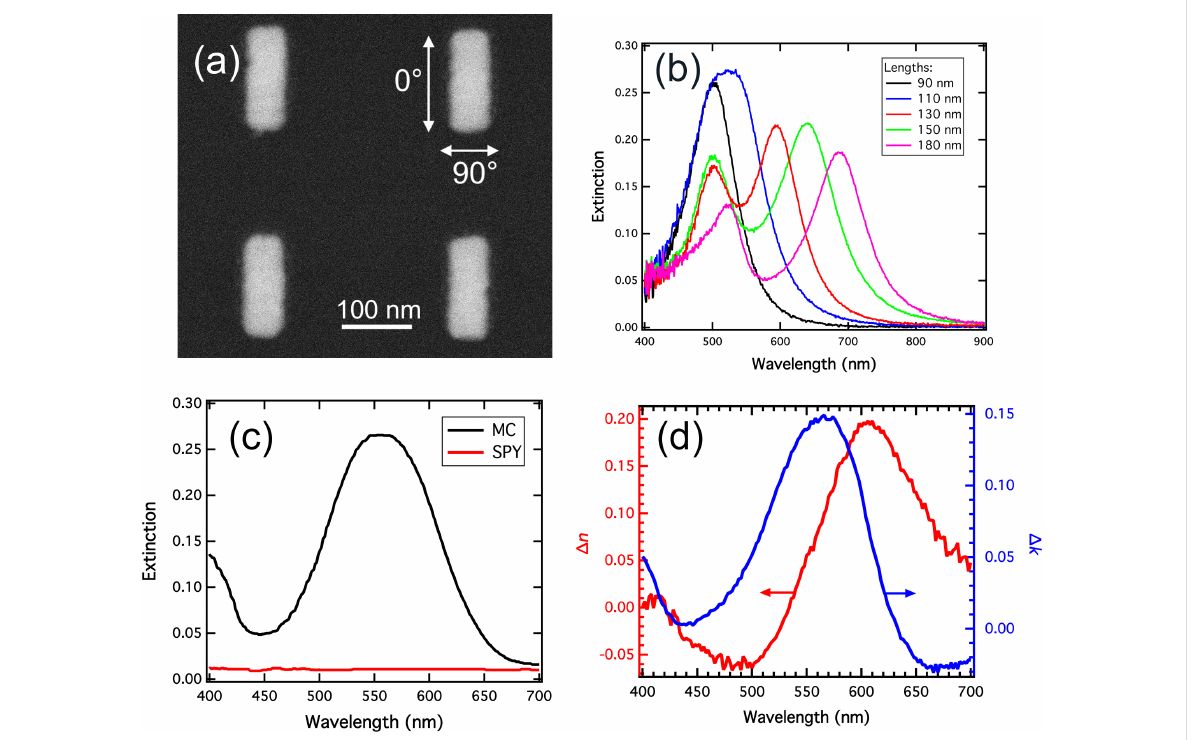
Figure 1: (a) SEM image of silver nanorods. The 0° and 90° polarization orientations correspond to the nanorod long and short axes, respectively. (b) Extinction spectra of silver nanorods in air. The width is 90 nm and the lengths vary from 90 to 180 nm. (c) Absorbance spectrum of a 60 nm thick active layer before (SPY) and after (MC) the photochromic transition. (d) Variations of the refractive index real and imaginary parts of the organic layer due to the photochromic transition, measured by